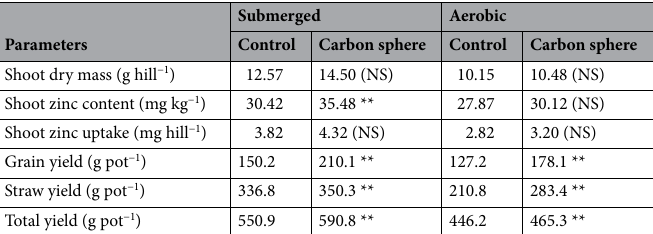
Table 3. Zinc loaded carbon sphere application and Yield parameter of rice ( Oryza sativa L). Notes NS-Non Significance. **Significance.